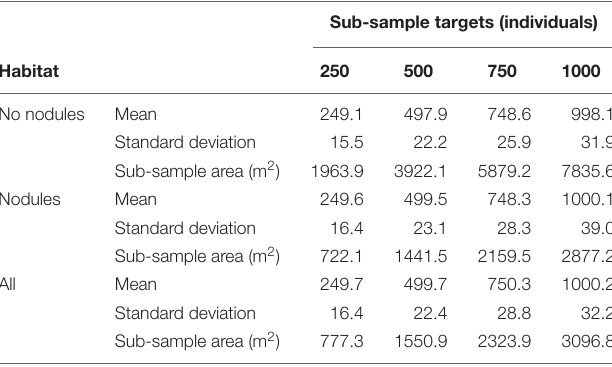
TABLE 3 | The degradation treatments and their mean impacts on abundance and morphospecies richness, across the four sub-sample sizes (250, 500, 750, 1000 individuals), without differentiating habitat (i.e., the “All” class).